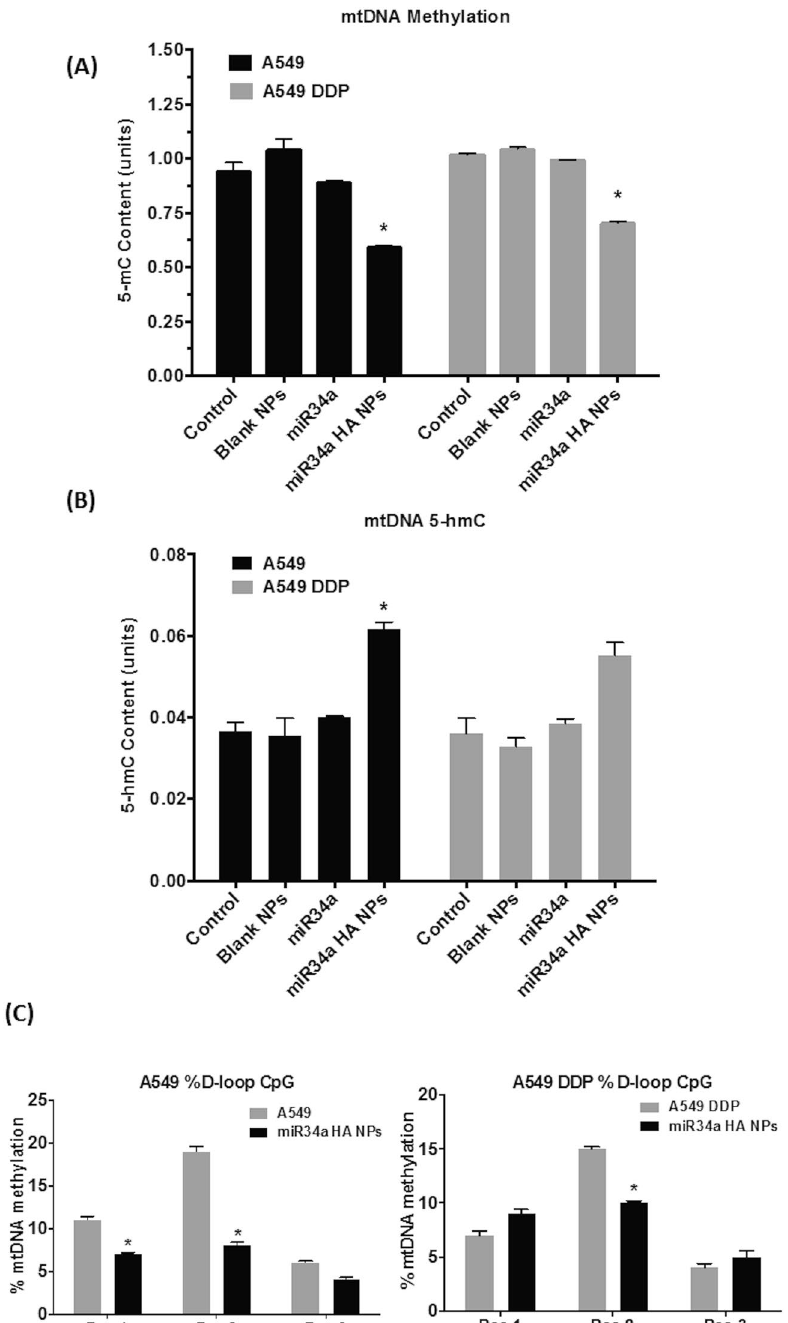
Figure 5. Effect of miR34a transfection with HA-based nanoparticles on mitochondrial DNA (mtDNA) Methylation levels. Mitochondria was isolated from A549 and A549 DDP cells post-transfection with miR34a HA-NPs (50 nM; 24 hours) DNA was isolated from this mitochondria and global (A) 5-methylcytosine (5- mC) (B) 5-hydroxymethylcytosine (5-hmC) content were measured with equal amounts of mtDNA using 5-mC and 5-hmC enzyme linked immunosorbent assay (ELISA) assays. Blank NPs–Blank HA-PEI/HA-PEG nanoparticles, miR34a - Naked miR34a without encapsulation, miR34a HA-NPs–microRNA34a encapsulated in HA-PEI/HA-PEG nanoparticles. (C) miR34 a HA-NPs induced changes in site-specific methylation content for individual CpG sites on the promoter regions of D-loop on mt-DNA as determined by bisulfite conversion followed by pyrosequencing. Pos1–3 indicates individual CpG sites. Results are expressed in units (mean + / − standard error of the mean [SEM]); n = 6; * p < 0.05 compared to the corresponding